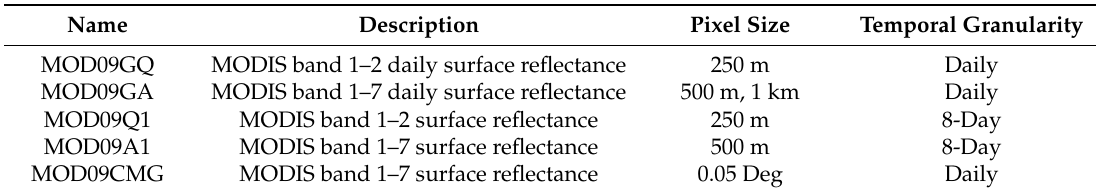
Table 1. MOD09 product description (Collection 5).